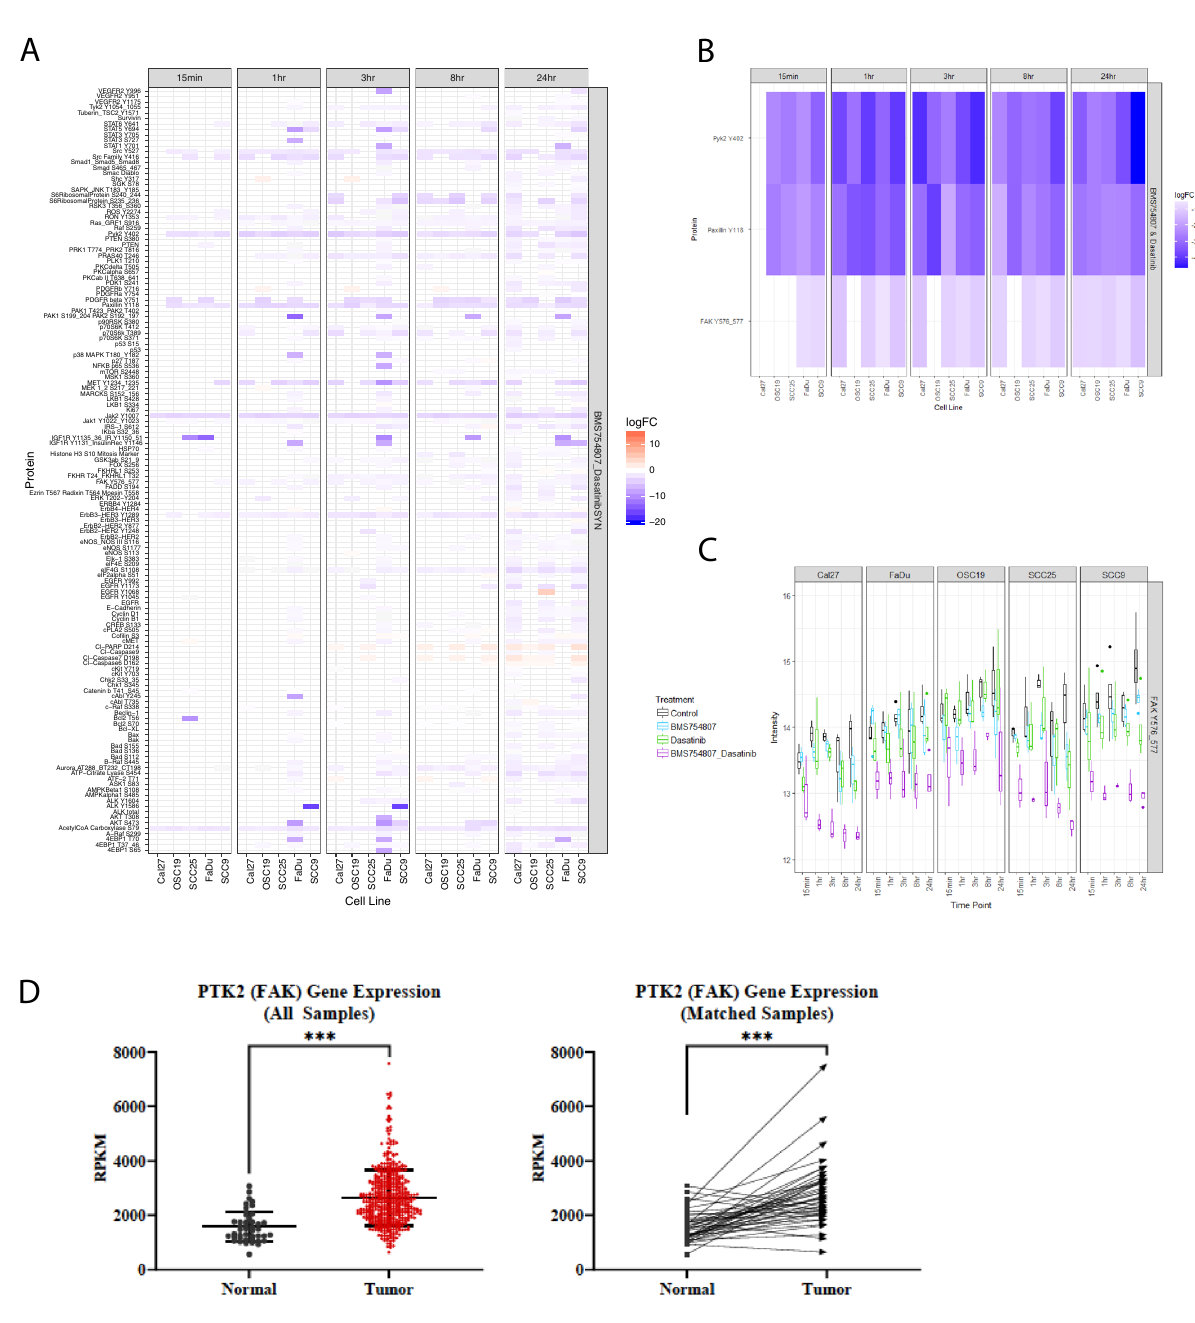
Figure 1. Focal adhesion proteins that are upregulated in HNSCC are synergistically decreased with BMS754807 and dasatinib. Lysates from five HNSCC cell lines were assessed by reverse phase protein array (RPPA) to determine protein changes following treatment with vehicle, each single drug, or the combination at 15 min, 1 h, 3 h, 8 h and 24 h. Synergistic changes are defined as “Log Fold Change (LogFC) in combination— (1/2LogFC Drug 1)—(1/2LogFC Drug 2)” with a false discovery rate (FDR) < 0.05. ( A ) Representative heat map depicting all synergistic changes among the 145 epitopes assessed by RPPA. ( B ) Heat map depicting synergistic changes in the focal adhesion proteins Pyk2 Y402, Paxillin Y118 and FAK Y576-577. ( C ) Graphs depict changes in protein expression from treatment with control, BMS754807, dasatinib or BMS754807 and dasatinib combination. ( D ) mRNA expression in tumor or normal head and neck tissues from the TCGA panCancer Atlas. The “All Samples” graph depicts the reads per kilobase of transcript per million mapped reads (RPKM) value from 522 tumor samples and 44 normal samples. The “Matched samples” compares the RPKM of 43 patients with both tumor and normal